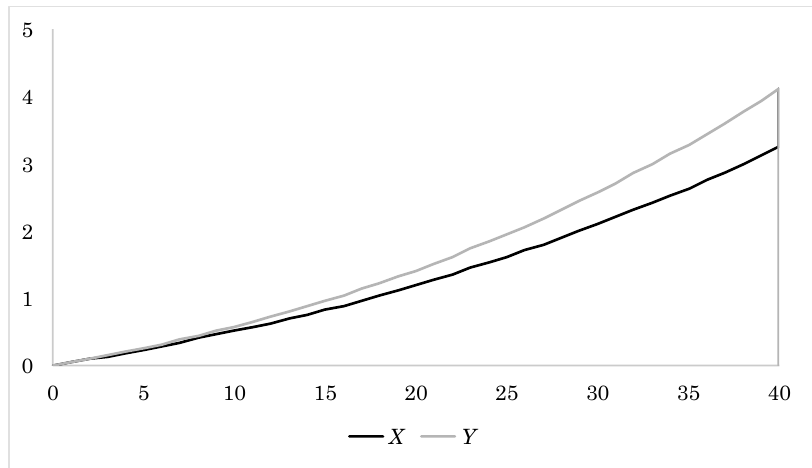
Figure 9. Approximated expected assets X and guarantee account Y as a function of time.